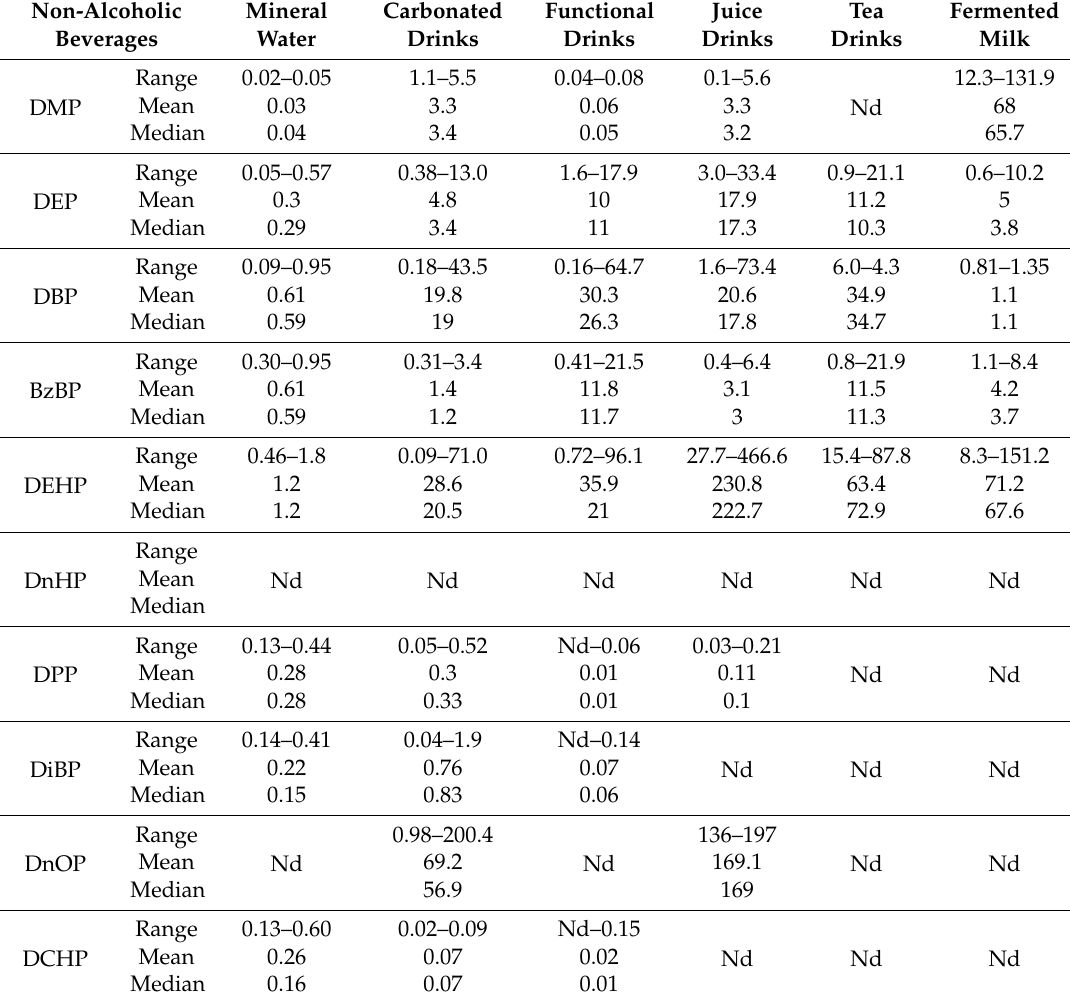
Table 8. Phthalate concentrations in different types of non-alcoholic beverages ( µ